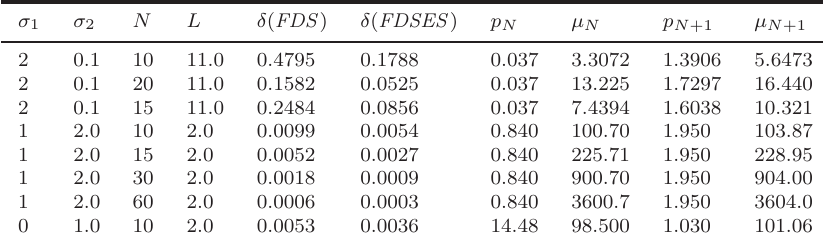
Table 1. The values of σ 1 , σ 2 , N , L , δ ( FDS ), δ ( FDSES ), p N , µ N , p N +1 , µ N +1 .